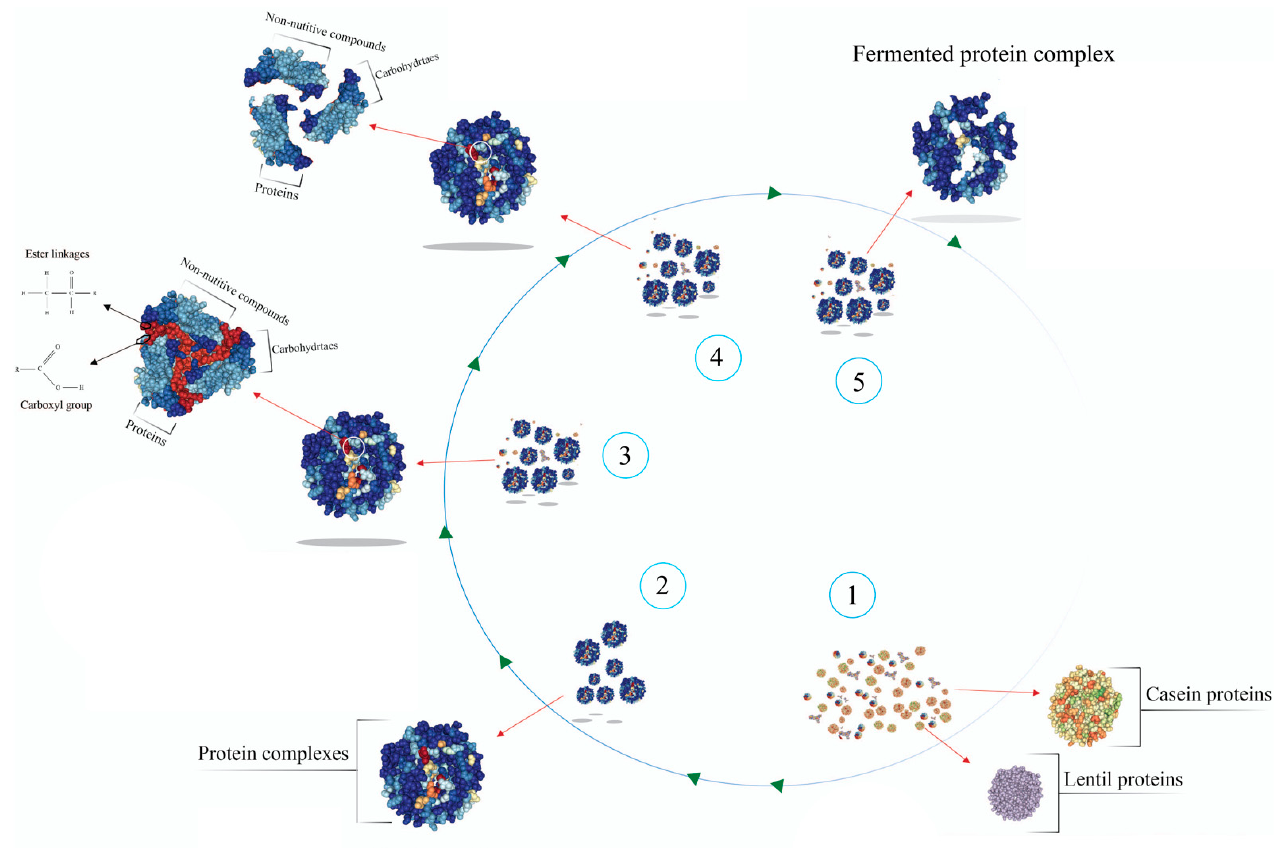
Figure 3. Schematic diagram of the mechanism of dual technology (based on protein–protein interac- tion and fermentation) to generate lentil–casein protein complexes (LCPC) with improved nutrition and protein functionalities. (1) The protein solution (1% w / v ) contains lentil proteins (LP) and casein proteins (CP) at a ratio of 1:0.1 in distilled water. The pH of the protein solution was adjusted to 12 for 60 min, then was readjusted to 7.0. (2) Soluble protein composites with novel protein structures were formed based on the structural interaction of lentil proteins and casein. (3) Fermentation was performed for 5 days at 25 ◦ C with a protein complex of (1%, w / v ), water kefir (5%, v/v ), and distilled water (95%, v/v ). (4) microorganism that synthesizes enzymes capable of breaking ester links and consequently releases free soluble phenols. (5) Fermented protein complexes have high digestibility, nutritional value, and soluble proteins.